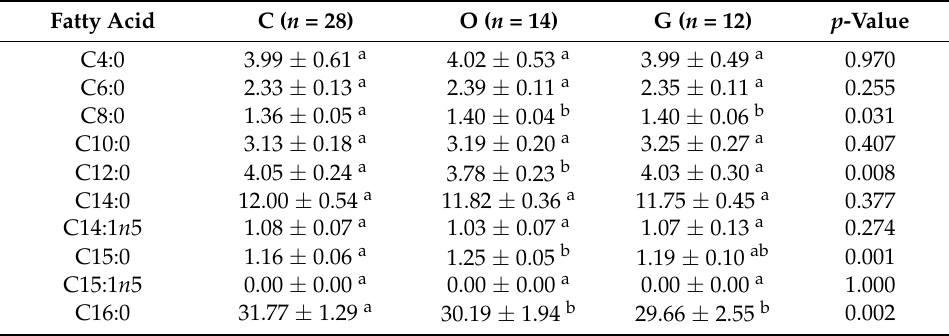
Table 3. Average fatty acid composition of conventional (C), organic (O), and grass (G) retail full ‐ fat butters; mean concentration, standard deviation and significant differences between butter types (Kruskal–Wallis).